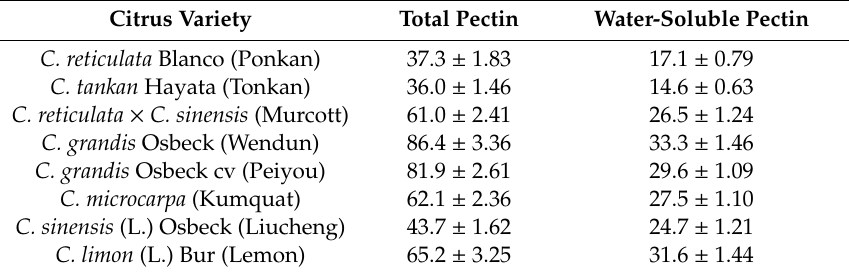
Table 10. Pectin composition in the peels of di ff erent varieties of citrus fruits grown in Taiwan (mg / g, dried base)